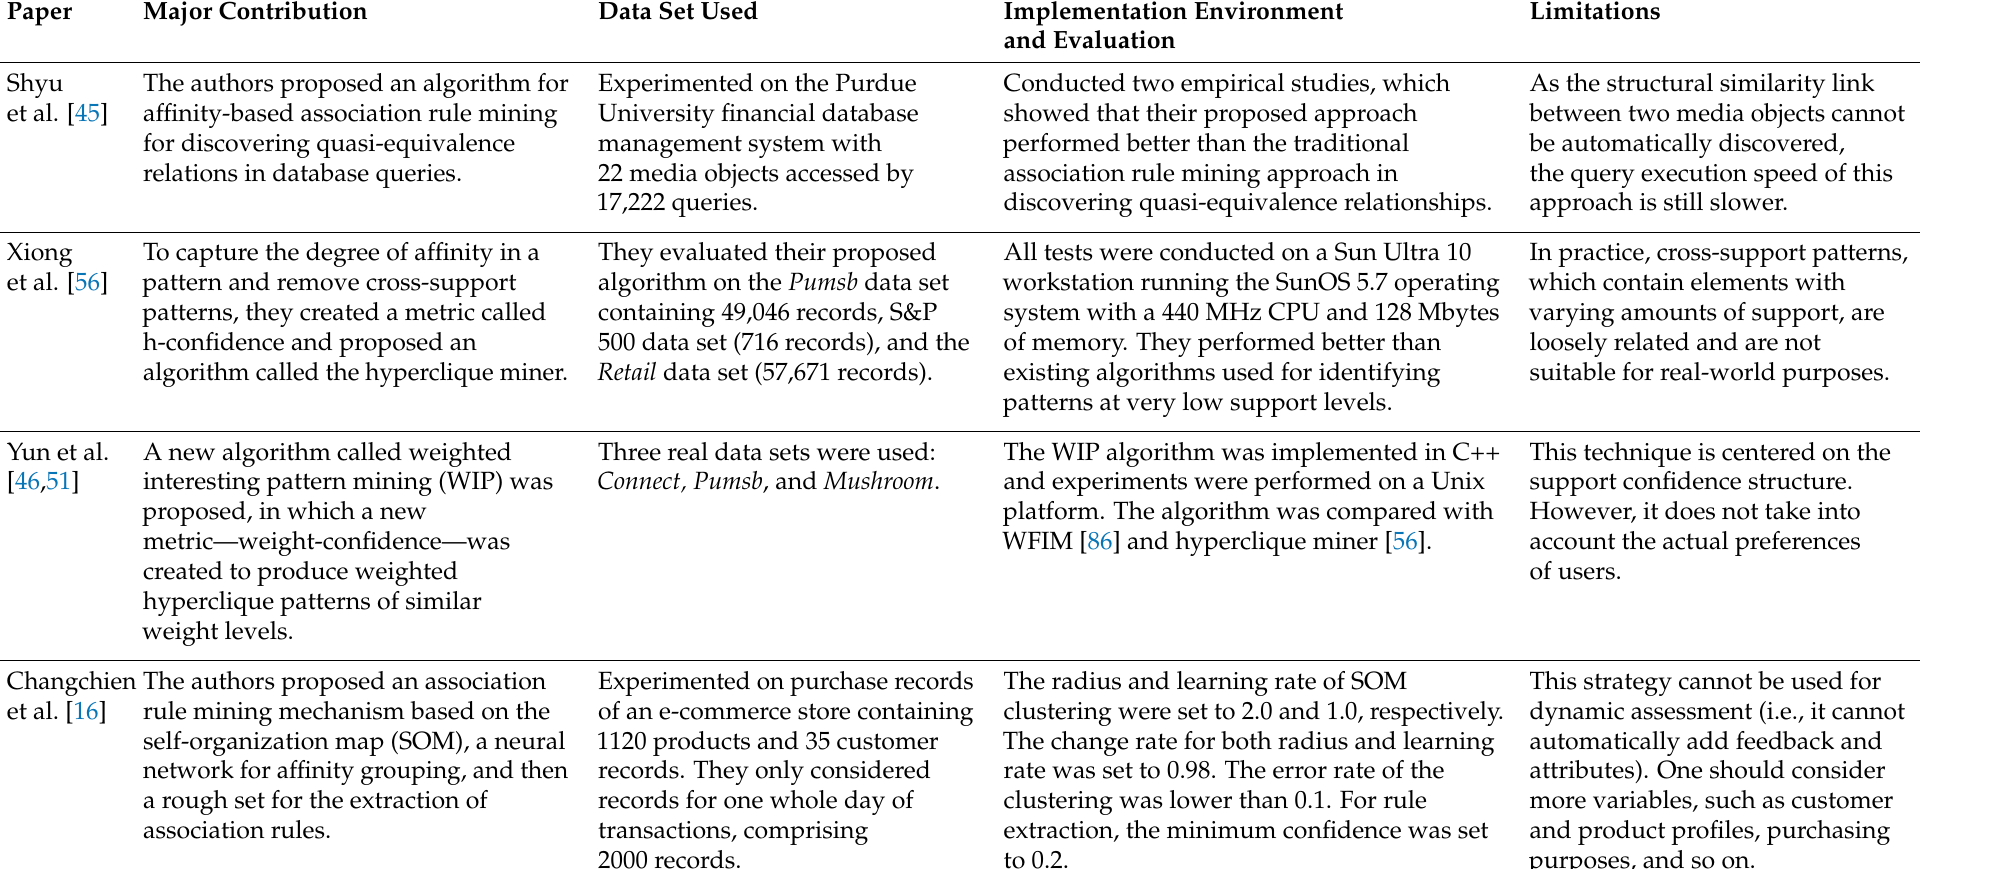
Table 3. Summary of the research on affinity